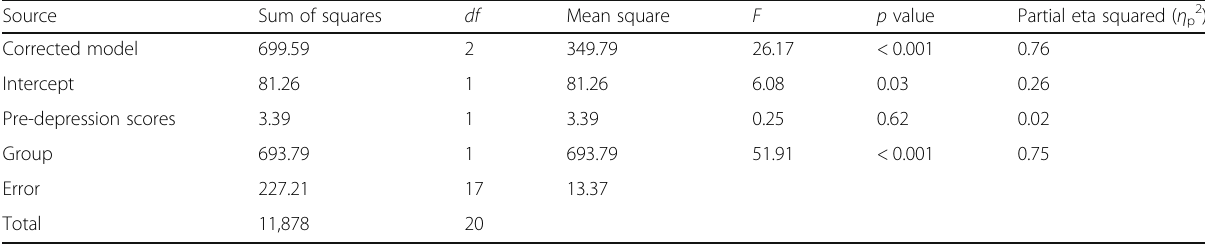
Table 3 Results of ANCOVA test for CBT treatment group